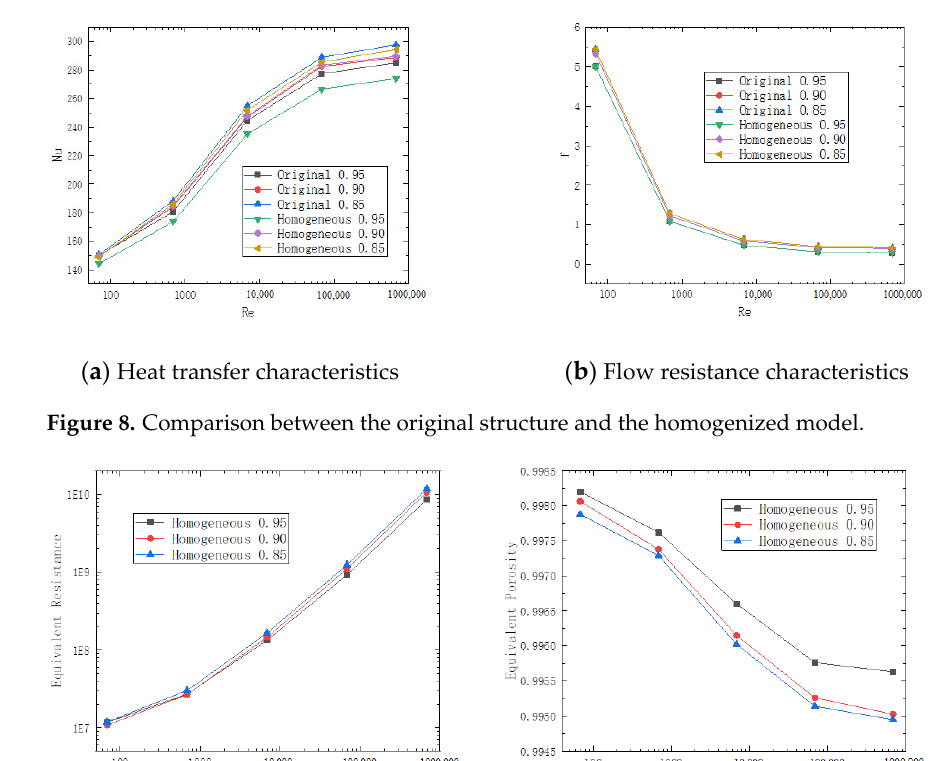
( b ) Flow resistance characteristics Figure 7. Heat transfer and flow resistance characteristics. 4.2. Comparison of Equivalent Homogenization Models As the original real porous structure of metal foams is very complex, difficult to cal- culate, long cycle, and high cost, the porous media homogenization equivalent model is used for alternative calculation. When using the homogeneous equivalent model of po- rous media, two important parameters, resistance coefficient and porosity, should be given. The resistance coefficient affects the velocity and pressure variation of the fluid passing through the porous media homogenization model, which also affects the heat transfer characteristics. The porosity affects the overall thermal physical properties of po- rous media homogenization model and the heat transfer performance. According to the previous analysis, both the resistance coefficient and porosity need to be calculated through a mathematical model, which is half theoretical and half empirical, and this math- ematical model requires extensive design calculations to obtain. Figure 8 shows the com-